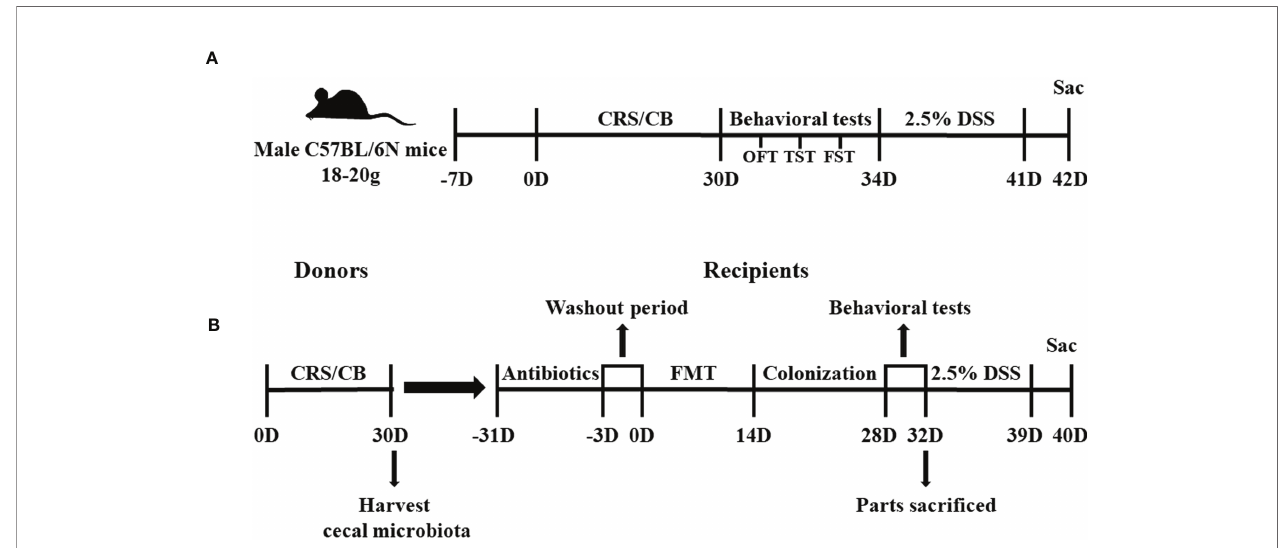
FIGURE 1 | Study timelines of Experiments 1 and 2. (A) Graphical timeline of Experiment 1 including CRS and DSS-induced colitis. (B) Graphical timeline of Experiment 2 including antibiotic treatment and FMT. CRS, chronic restraint stress; DSS, dextran sodium sulfate; FMT, Fecal microbiota